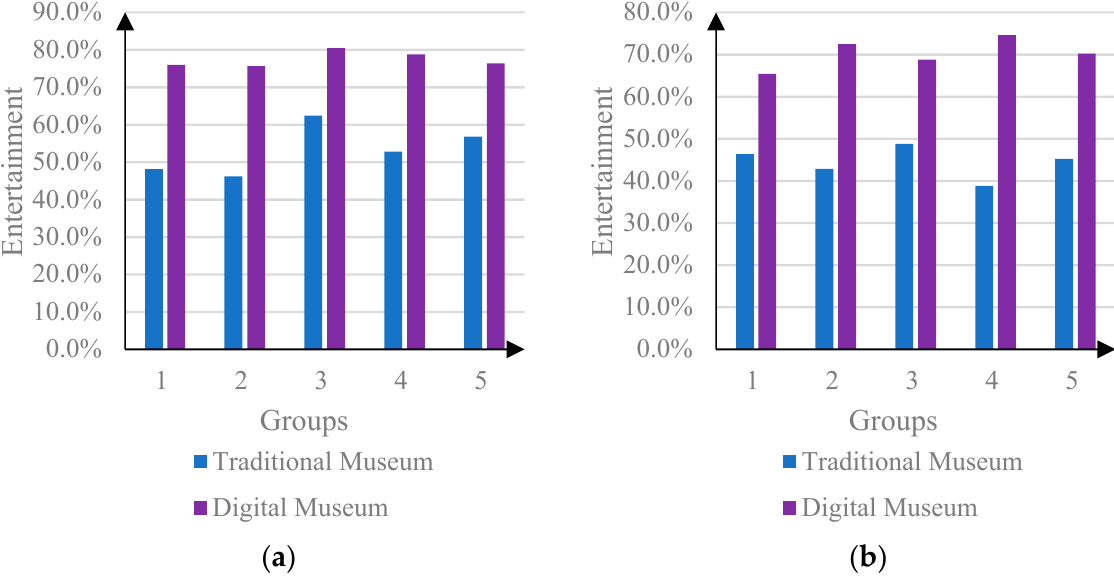
Figure 6. Entertainment comparison results. ( a ) Amusement of museums from the perspective of young people, ( b ) Amusement of museums from the perspective of the elderly.